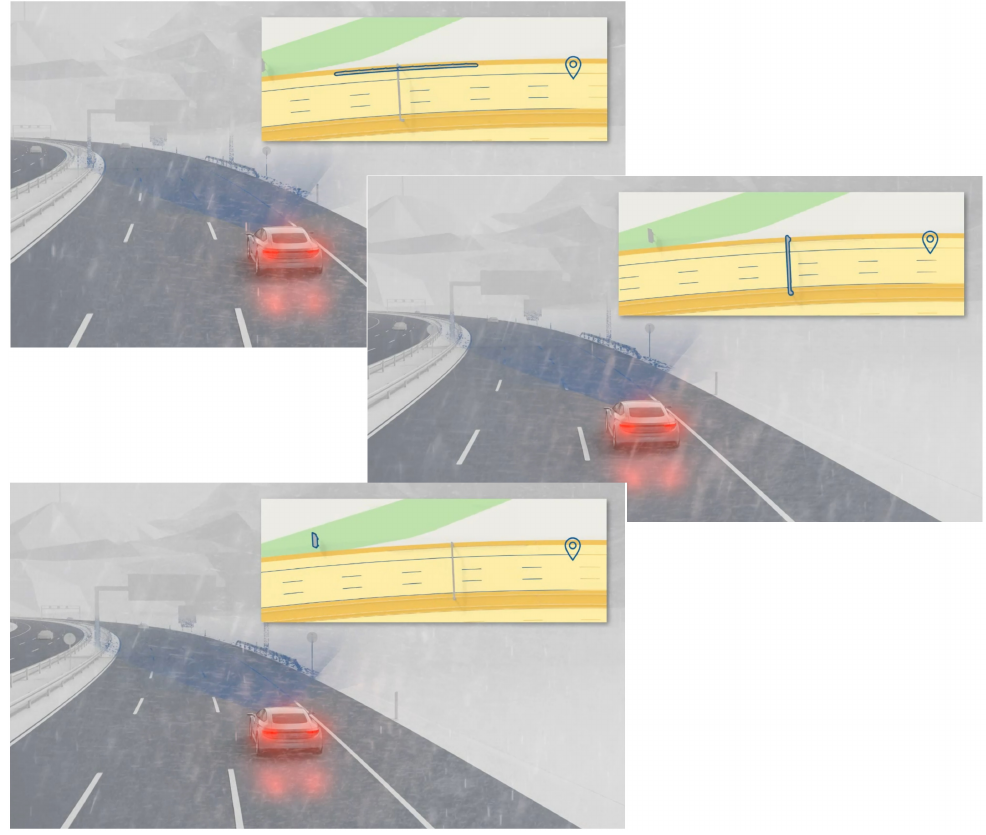
Figure 1. An illustration of the expected upcoming events that the autonomous car must be aware of. By having an accurate localization system, the vehicle can precisely locate the next upcoming events, so that the vehicle knows what action must be taken in the next seconds. Image source: extracted from Bosch’s video